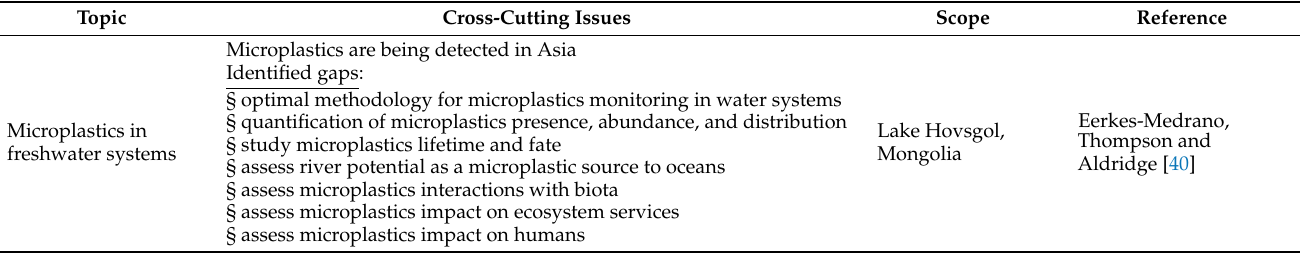
Table 4. A total of 15 selected studies addressing riverine pollution in Asia (sorted by publication